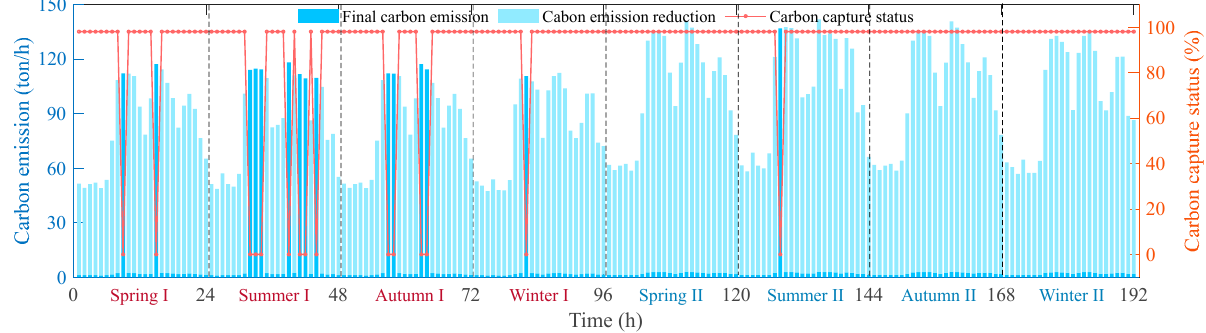
Figure 10. Carbon Emission and Capture during Limestone Calcination in Two Stages of Case 1.